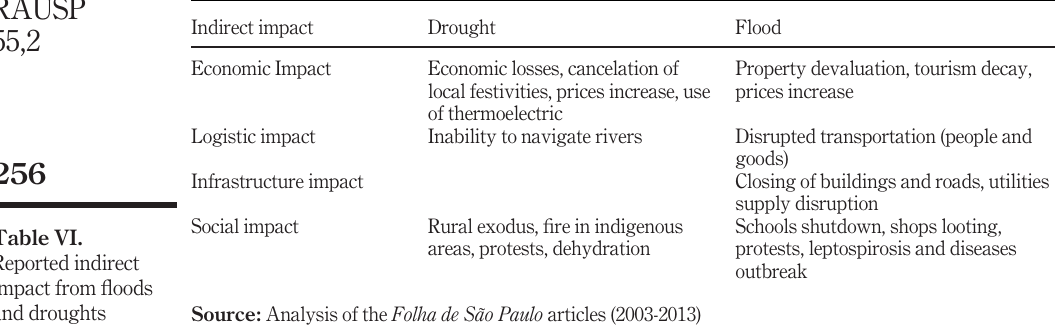
Table VI. Reported indirect impact from fl oods and droughts